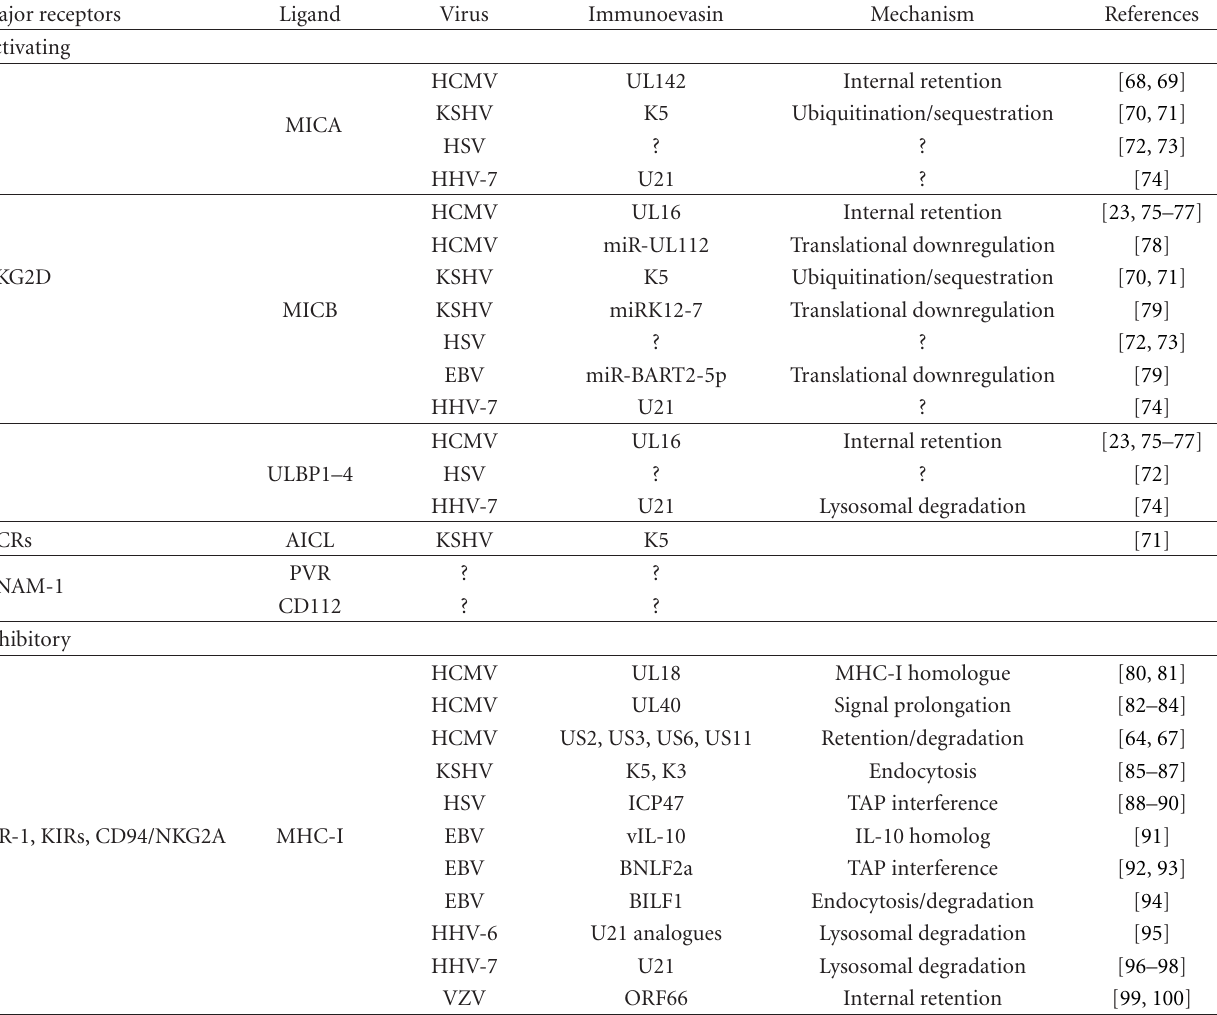
Table 1: Summary of known interactions between NK cell receptors, ligands, and herpesvirus